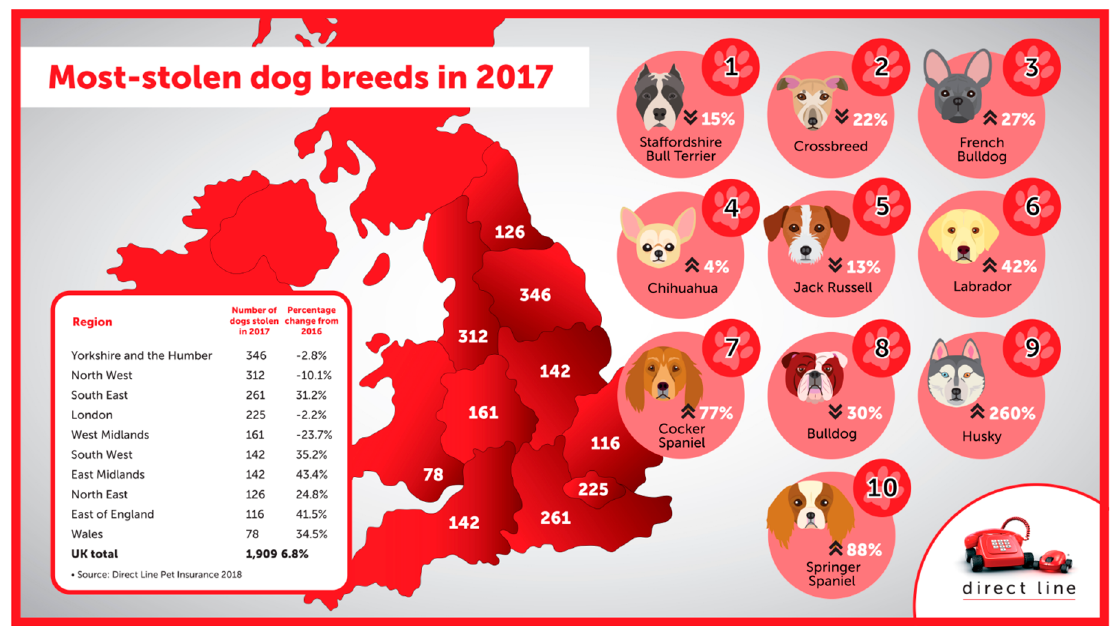
Figure 1. Most stolen dog breeds and total number of dogs stolen by regions of England and Wales in 2017 and associated changes since 2016 [27].